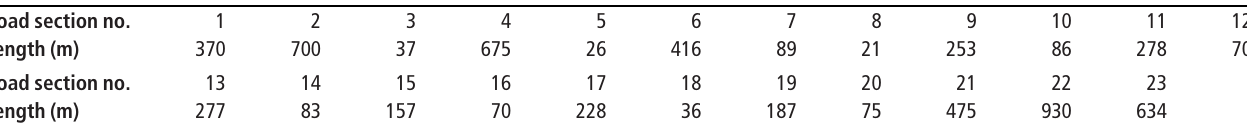
Table 3 Length of each road section on BRT 13 Road section no.